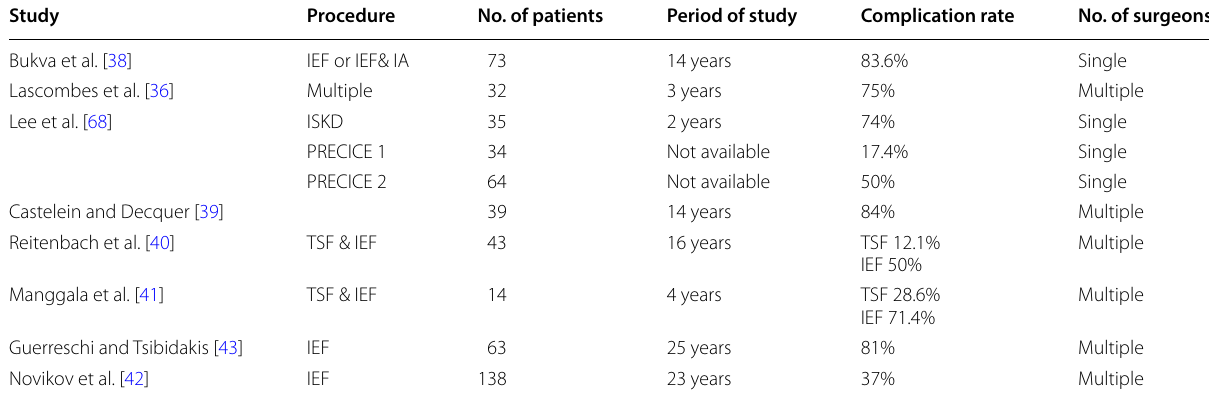
IEF Ilizarov external fixator, IA intramedullary alignment, ISKD Intramedullary Skeletal Kinetic Distractor, TSF Taylor Spatial